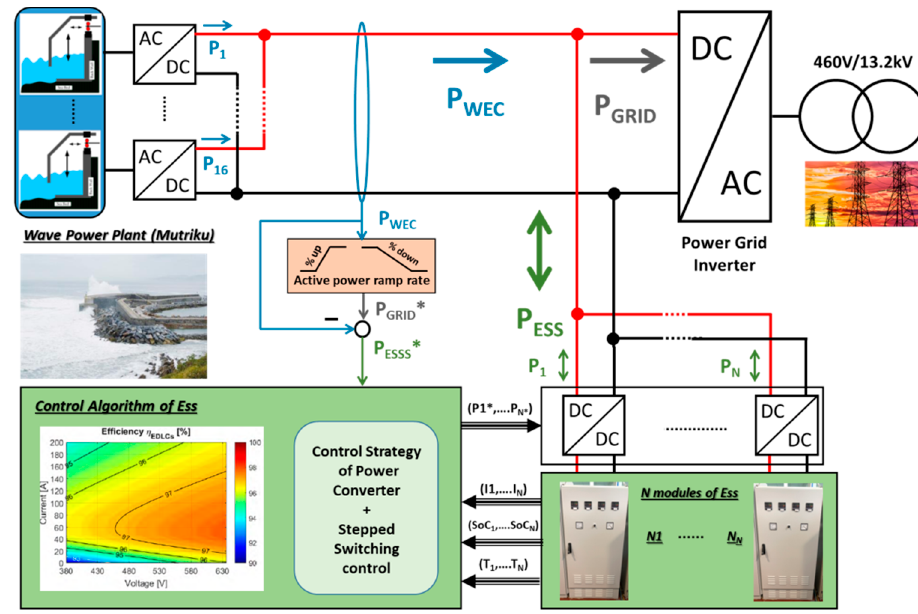
Figure 11. Simplified scheme of the model and control implemented in MATLAB ‒ Simulink. Table 1. Main input parameters of the simulation model.